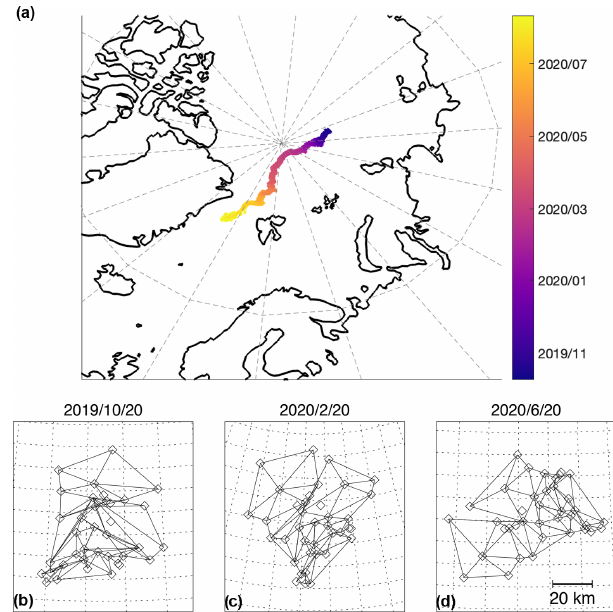
Figure 4. (a) Trajectories of the MOSAiC buoys from October 2019 to July 2020, with positions colored by date. (b–d) The MOSAiC buoys (diamonds) and triads (outlined with solid lines) as arranged for deformation calculation. The same array at three times is shown, with maps centered on (85.08 ◦ N, 132.9 ◦ E), (88.4 ◦ N, 65.9 ◦ E), and (81.9 ◦ N, 8.3 ◦ E) from (b) to (d) respectively. The scale of the maps is shown in the bottom right.